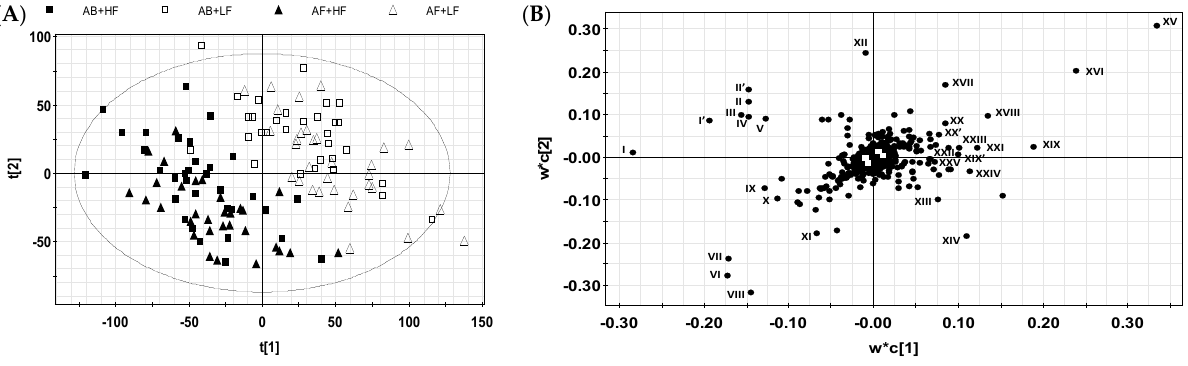
Figure 1. Identification of fecal metabolites altered by fiber and antibiotic in grow-finish pigs through metabolomic modeling. The LC-MS data of fecal samples from four treatment groups (AF + LF, AF + HF, AB + LF, and AB + HF) were processed by PLS-DA modelling. ( A ) The scores plot of PLS-DA model. The t[1] and t[2] are projection values of each sample in 1st and 2nd principal components of the model, respectively. ( B ) The loadings plot of PLS-DA model. The correlations of individual fecal ions with first and second components of the PLS-DA model were indicated by their respective w*c[1] and w*c[2] values. Major metabolites responsive to high fiber and antibiotic treatments are labeled and enlisted in Table